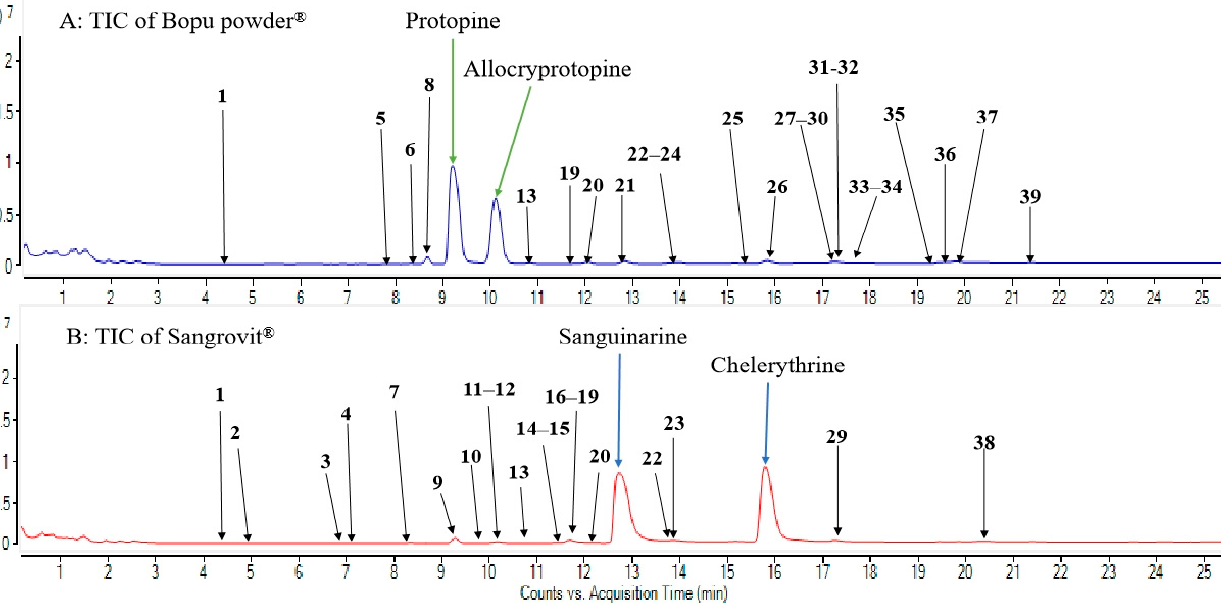
Figure 2. Total ion chromatograms (TICs) of ( A ) Bopu powder ® and ( B ) Sangrovit ® .